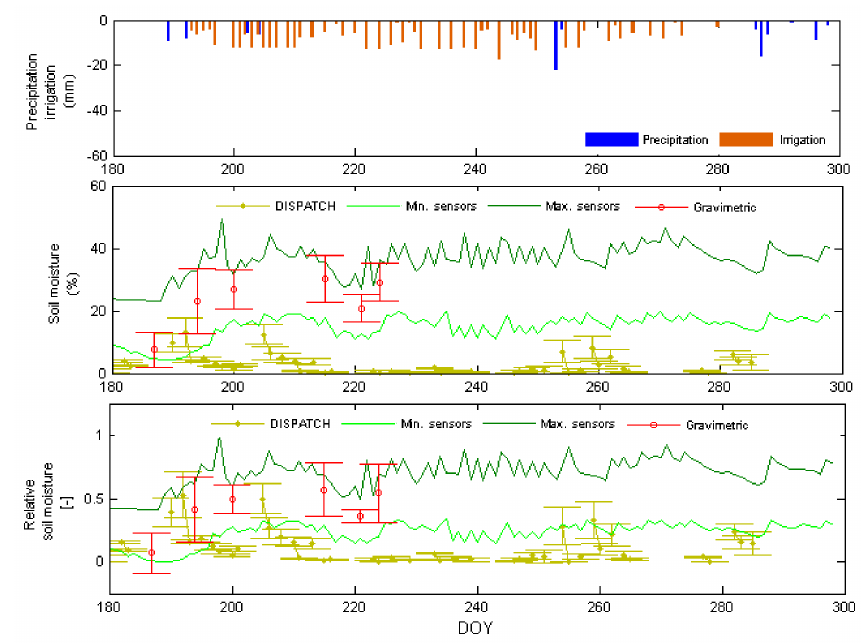
Figure 4. Comparison of average gravimetric soil moisture measurements (red) with the DISPATCH soil moisture estimations (yellow) and the daily maximum and minimum soil moisture sensor measurements (green) during the second hydrologic period (soil wet conditions caused by irrigation). The top figure shows the intensity of precipitation and irrigation.